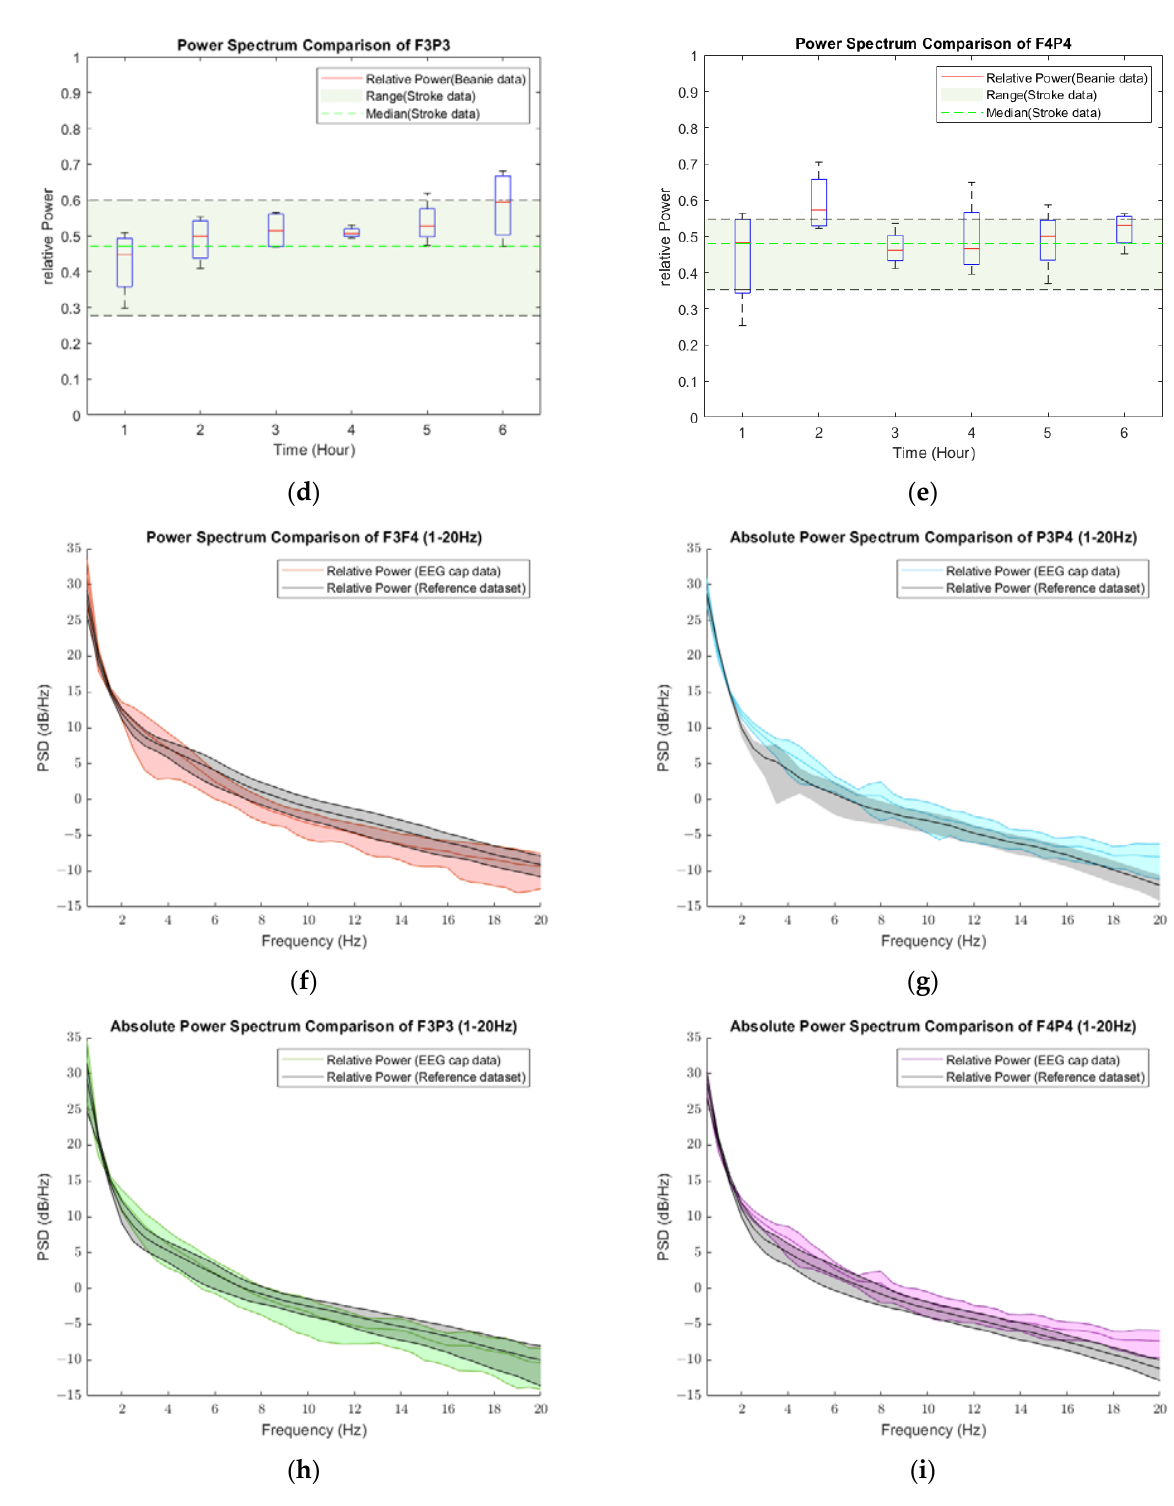
Figure 8. An example 10-s epoch of the raw EEG signals newborn infant with the novel EEG cap ( a ). Changes of 1–2 Hz relative power in different signal derivations and the corresponding measure are taken from a reference dataset (green zone). Asterisks denote time points with significant ( p < 0.05) differences between datasets ( b – e ). Comparison of the relative power of 1–20 Hz between the prototype cap and the historical dataset recorded with subdermal needle electrodes ( f – i